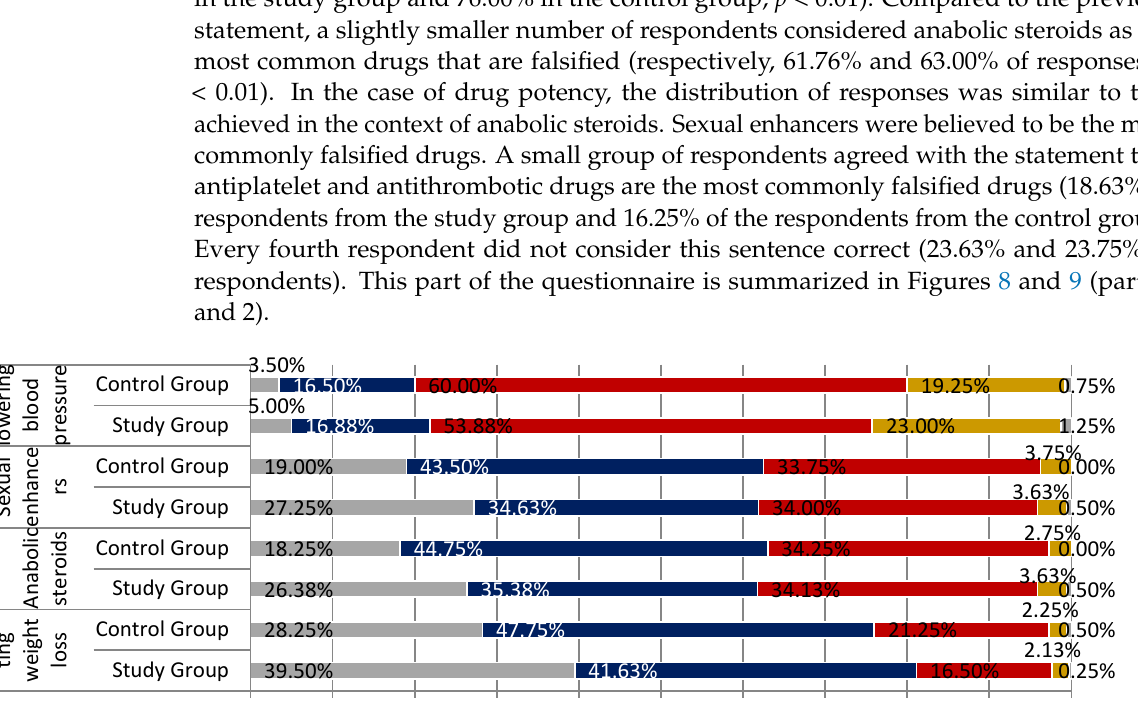
Figure 8. The most frequently falsified medicines in the opinion of respondents summary (part 1).